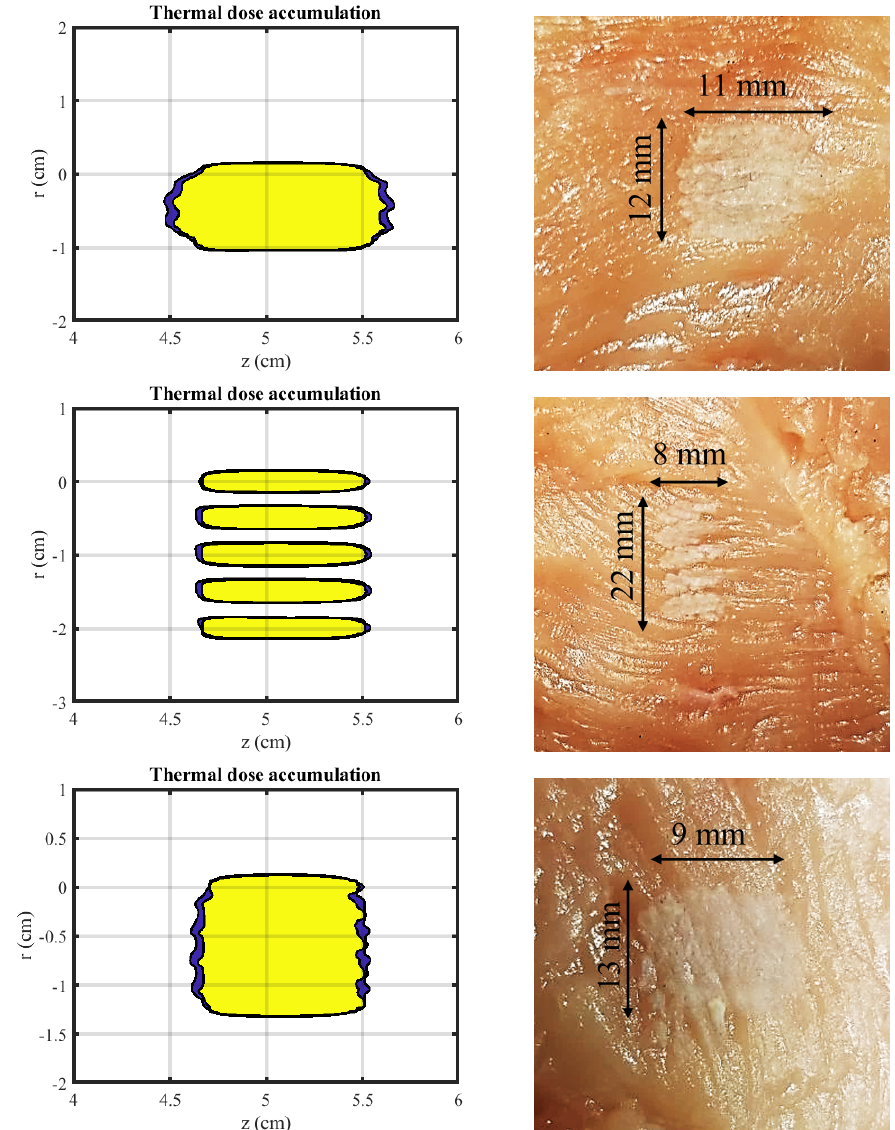
Figure 15. Comparison of the numerical simulation with the experimental treatment plan composed of 5